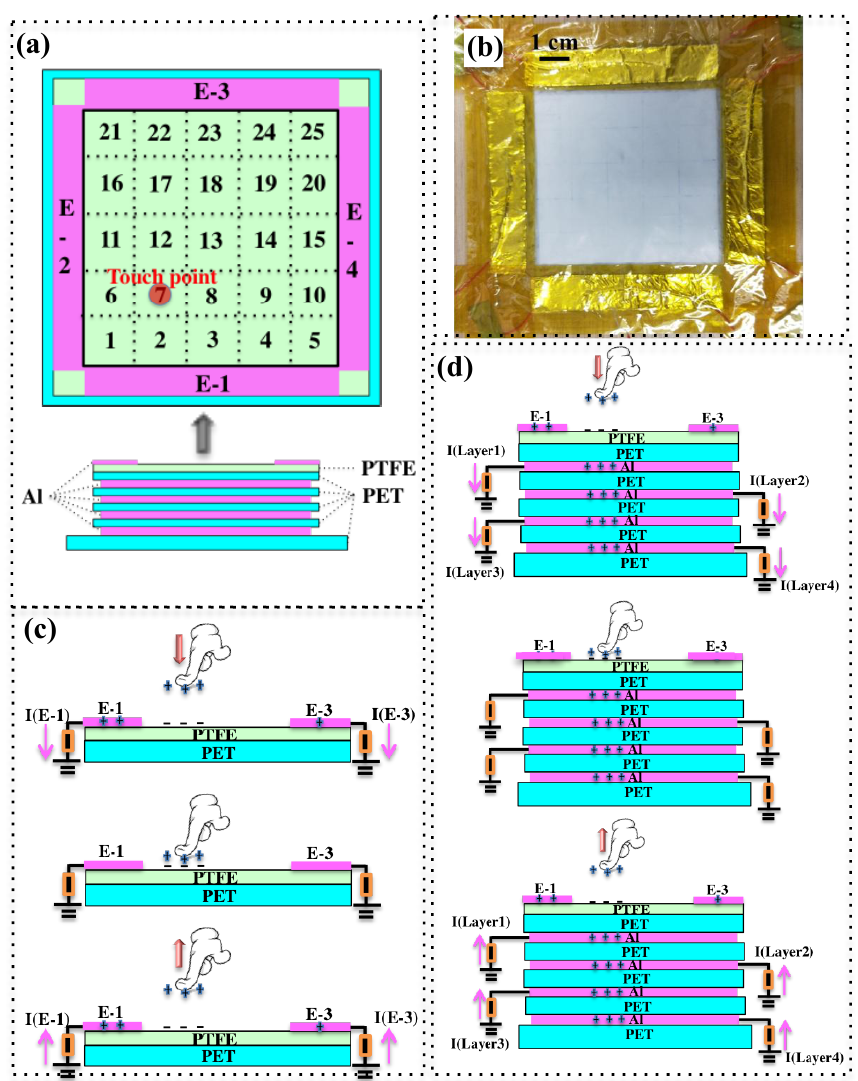
Figure 2. ( a ) Schematic illustration of the device from top view and side view, showing the four edge electrodes for position sensing and four stacking electrodes for energy harvesting. No. 1 to No. 25 denotes the virtual pixel (touch point) to facilitate finger contact test; ( b ) The photograph of the fabricated device; ( c ) The operation mechanism for position sensing of the device. Only the sensing part of the device is shown in the schematics; ( d ) The operation mechanism for energy harvesting of the device.